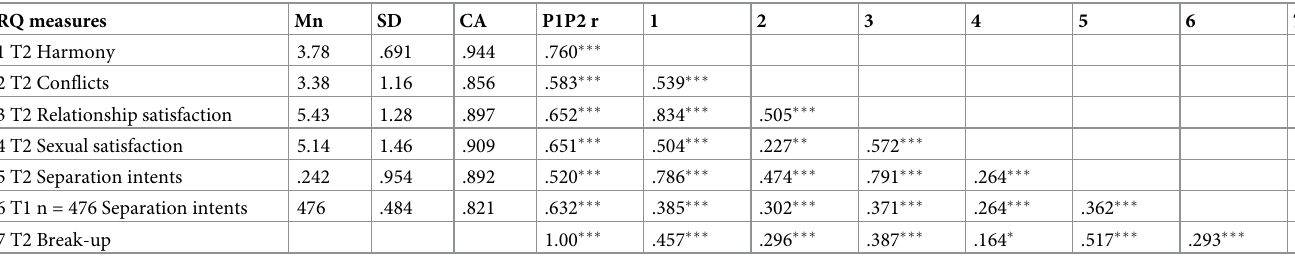
Table 3. Descriptive statistics about RQ (n = 192 for